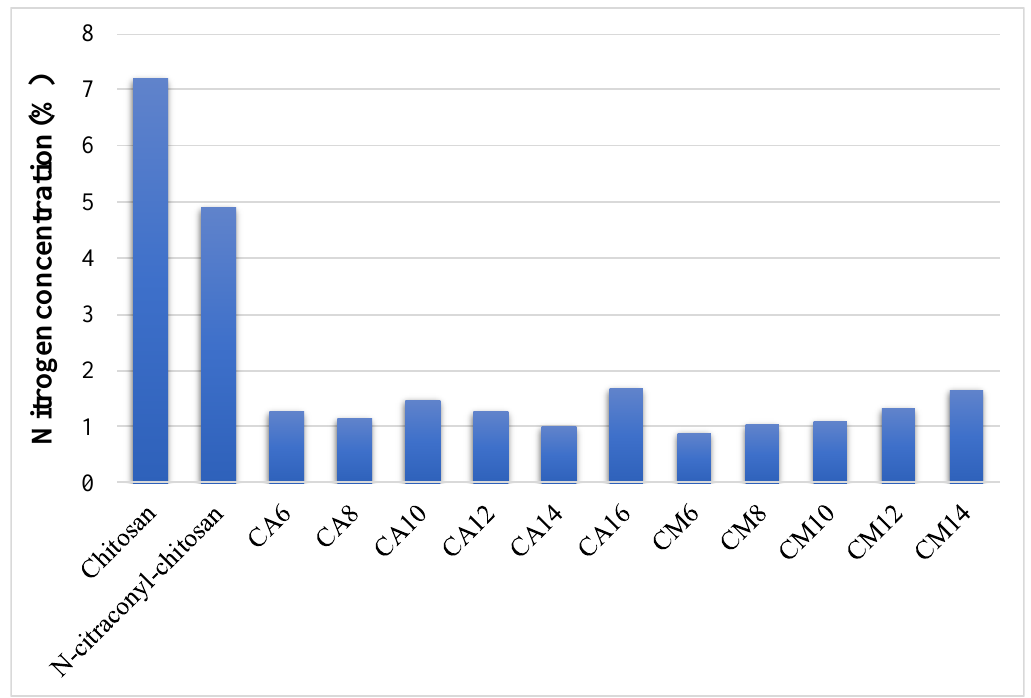
Figure 2. Nitrogen concentration of chitosan, N -citraconyl-chitosan and prepared hydrogels.